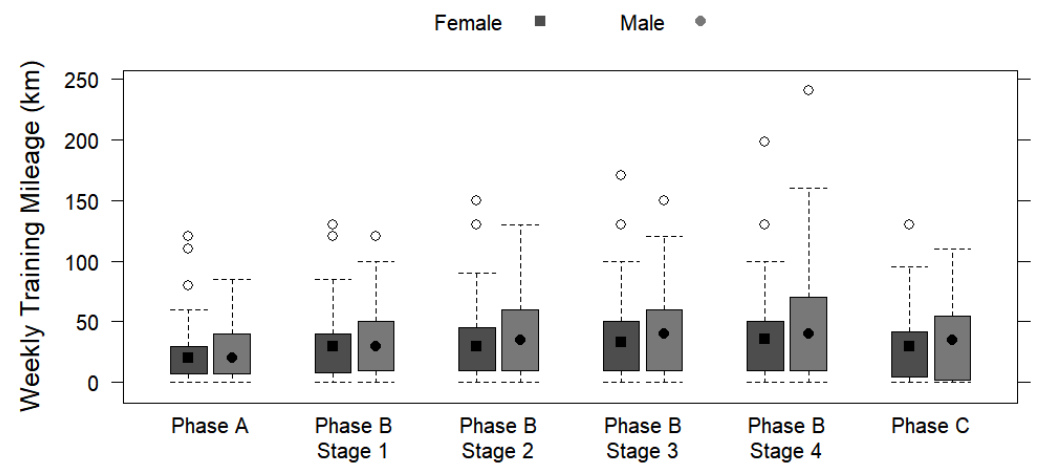
Figure 4. Box plots displaying sex differences in weekly training mileages (km) in different training periodization phases and stages.